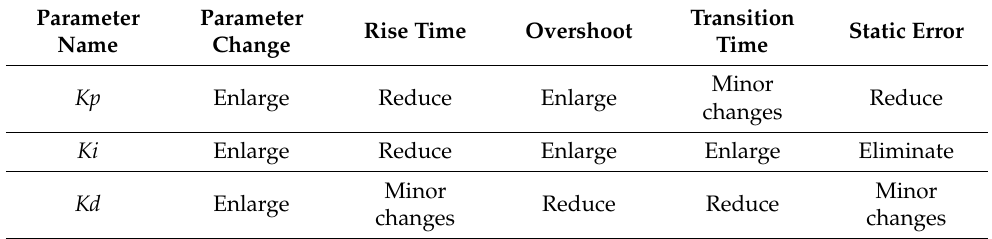
Table 2. Relationship between PID regulating parameters and system time domain performance indicators.